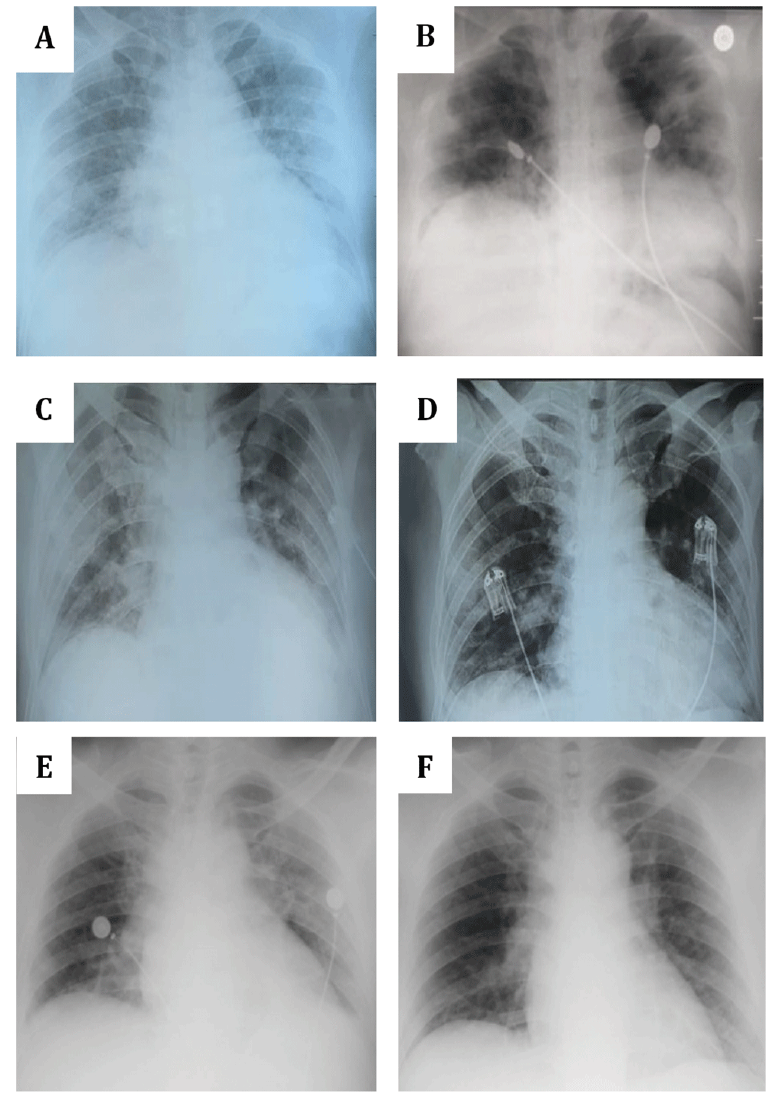
Figure 1. Chest X-ray of the three patients. ( A and B ) Patient 1 . ( A ) August 29 (a day post onset of illness (dpoi), showing bronchopneumonia with bilateral ground glass opacities (GGOs) and cardiomegaly; ( B ) September 10 (11 dpoi), showing the absorption of bilateral GGOs with no bronchopneumonia and cardiomegaly. ( C and D ) Patient 2 . ( C ) November 19 (3 dpoi), showing cardiomegaly with lung edema, bilateral GGOs aorta elongation and aorta atherosclerosis; ( D ) November 22 (6 dpoi), showing improvement with minimum infiltrate on pulmonalis dextra and sinistra. ( E and D ) Patient 3 . ( C ) December 23 (7 dpoi), showing worsened bilateral GGOs with cardiomegaly and aortic atherosclerosis; ( F ) December 28 (12 dpoi), showing decreased bilateral GGOs, cardiomegaly and aortic